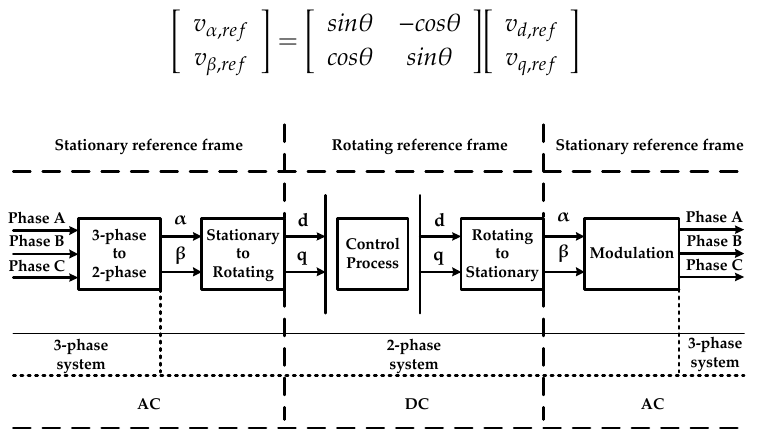
Figure 3. Overall domain transformation sequences involved in the VOC technique.